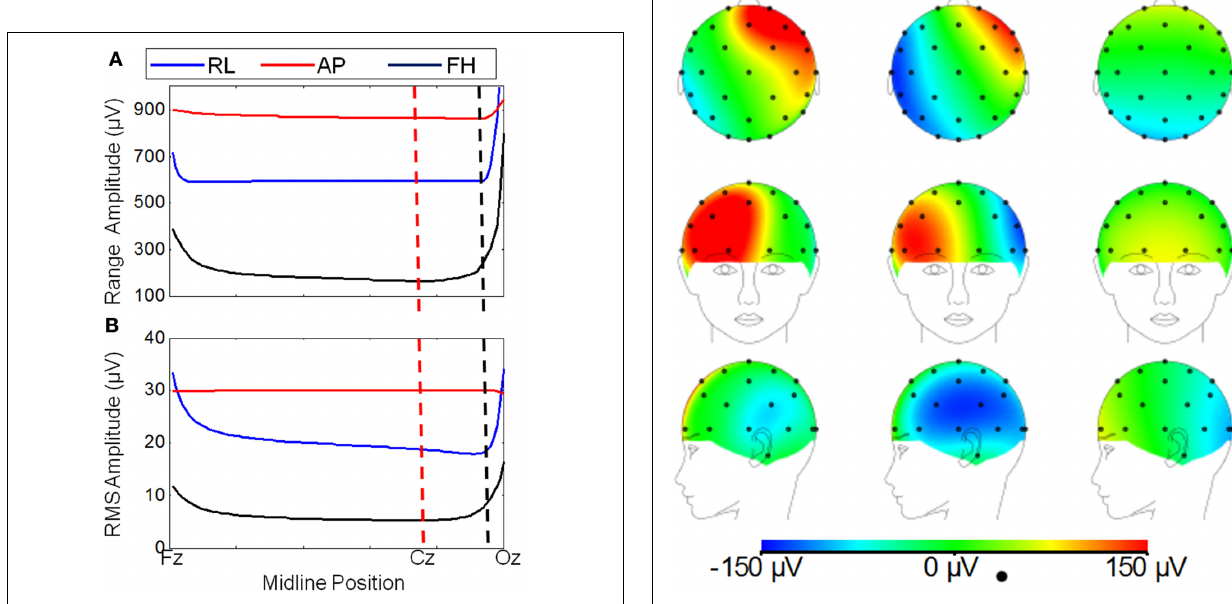
FIGURE 4 | Simulated artifact maps for a FH gradient at 2 Tm − 1 s − 1 for real lead paths (A), great circle lead paths converging in the conventional location (between electrodes Cz and Pz) (B) and great circle lead paths converging at the optimal location (electrode Cz)